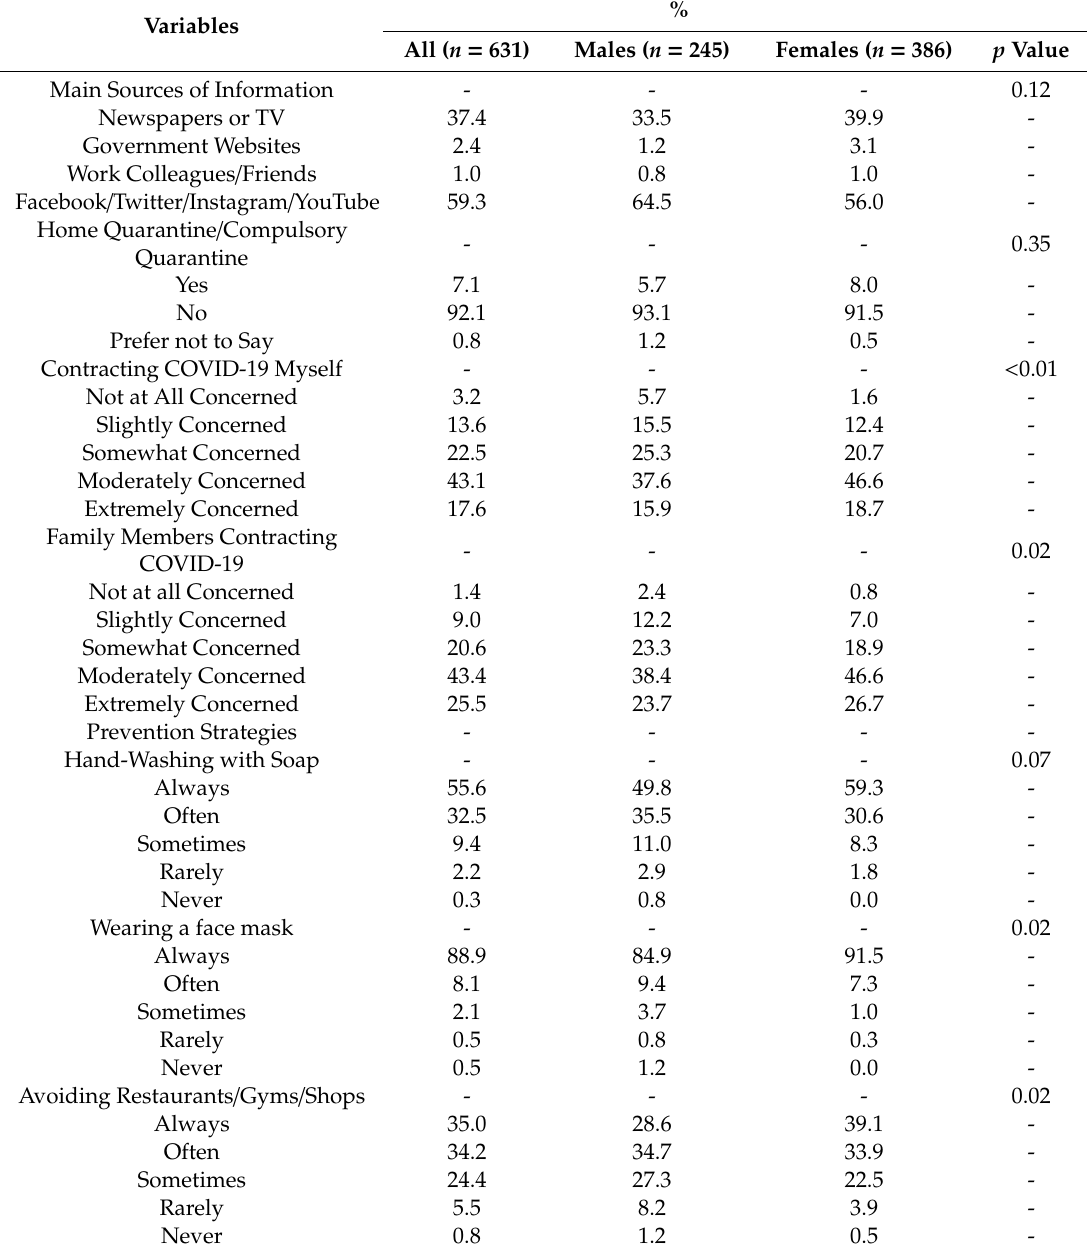
Table 3. COVID-19 related issues for cross-sectional study and stratified by sex.